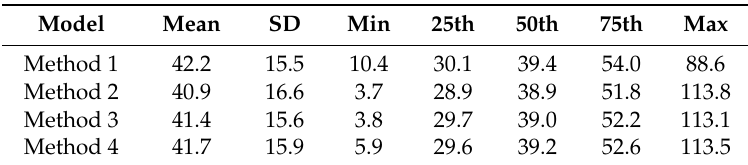
Table 1. Summary statistics comparing the result of the four different methods for daily O 3 concentrations at the the Gwangyang Bay industrial complex ( n = 2283). Model Mean SD Min